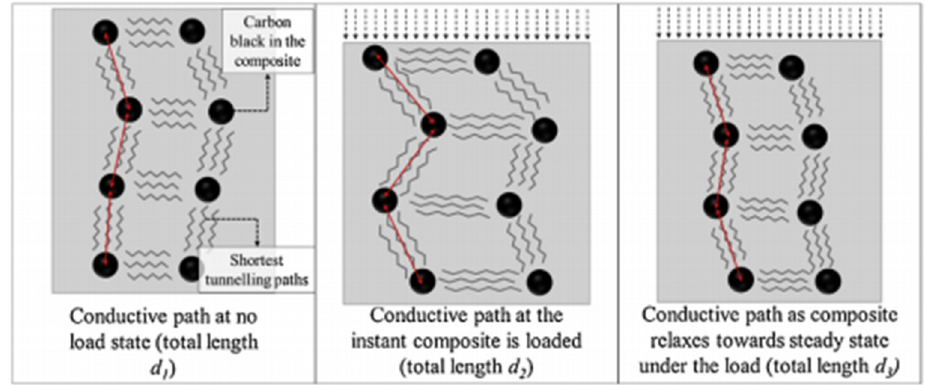
Figure 20. The e ff ect of pressure on a semi-conductive matrix [140] (Open Figure 20. The effect of pressure on a semi-conductive matrix [140] (Open Access).